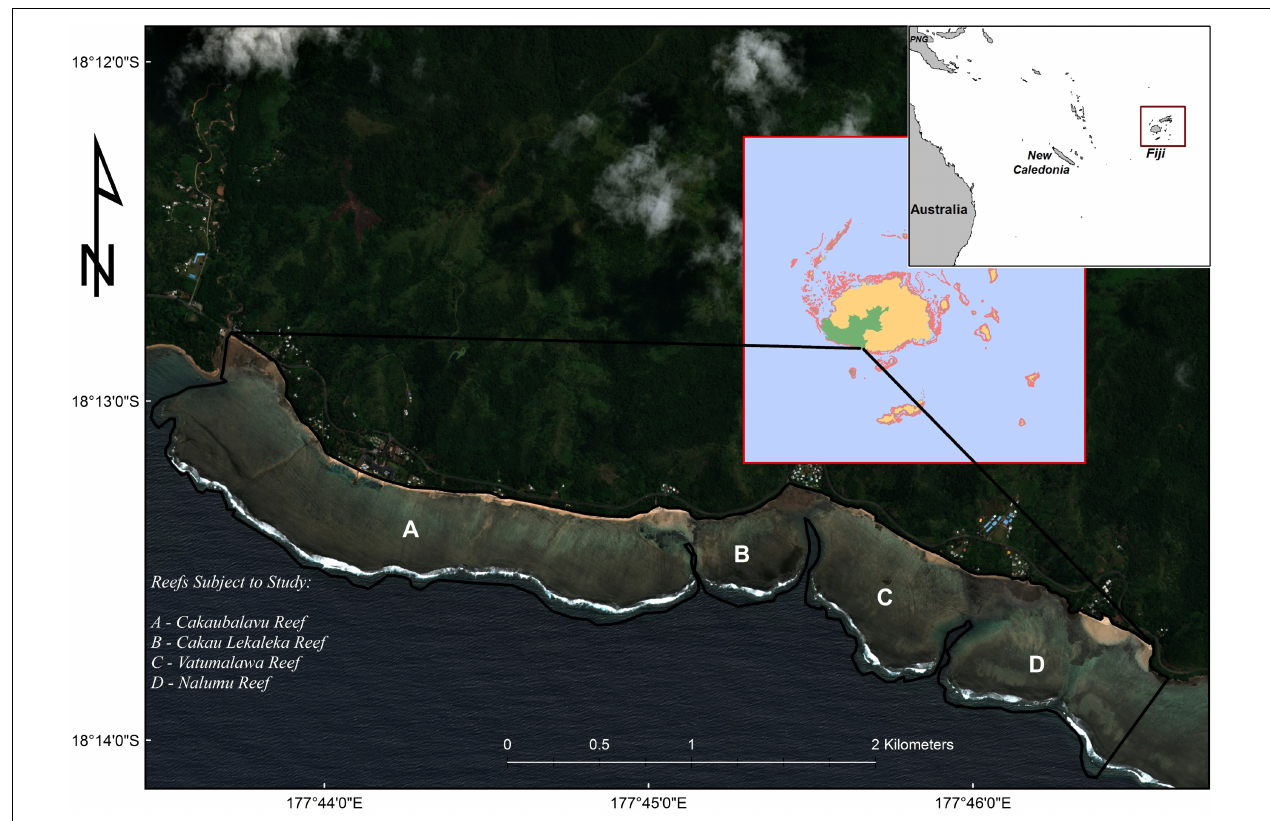
FIGURE 1 | Location of the Komave study site on the southwestern coast of the main Island Viti Levu in Fiji. Komave watershed shown in green in inset of Fiji. Alphabets represent different reefs; (A) Cakaubalavu , (B) Cakau Lekaleka , (C) Vatumalawa , (D) Nalumu .